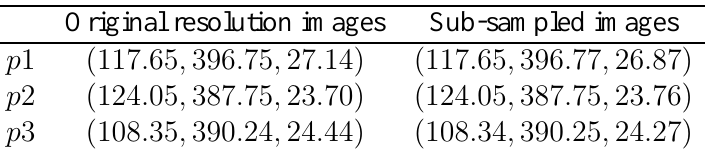
Table 3. Comparison of 3D modeling results in the cases original resolution and sub-sample